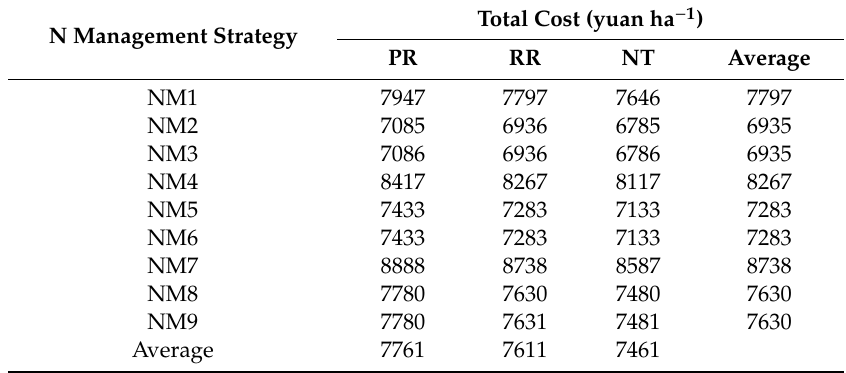
Table 8. Net return of wheat under various tillage methods and N management strategies.